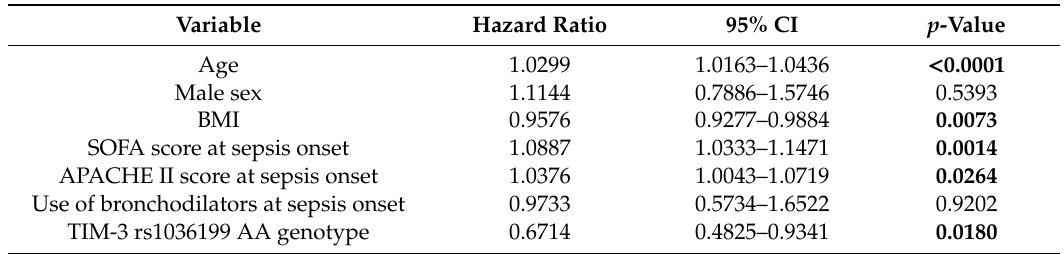
Table 5. Multivariate Cox regression analysis (28-day mortality) with regard to TIM-3 rs1036199 genotypes.